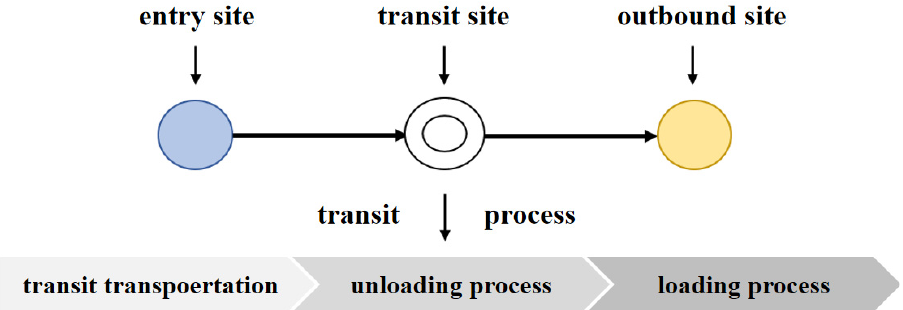
Figure 2. Workflow of integrated transportation network.